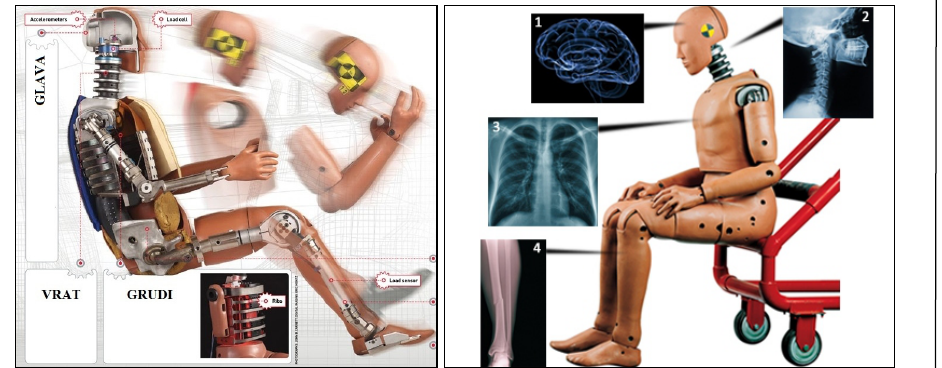
Figure 5 – Hybrid III dummy - doll designed for use in frontal motor vehicle crash